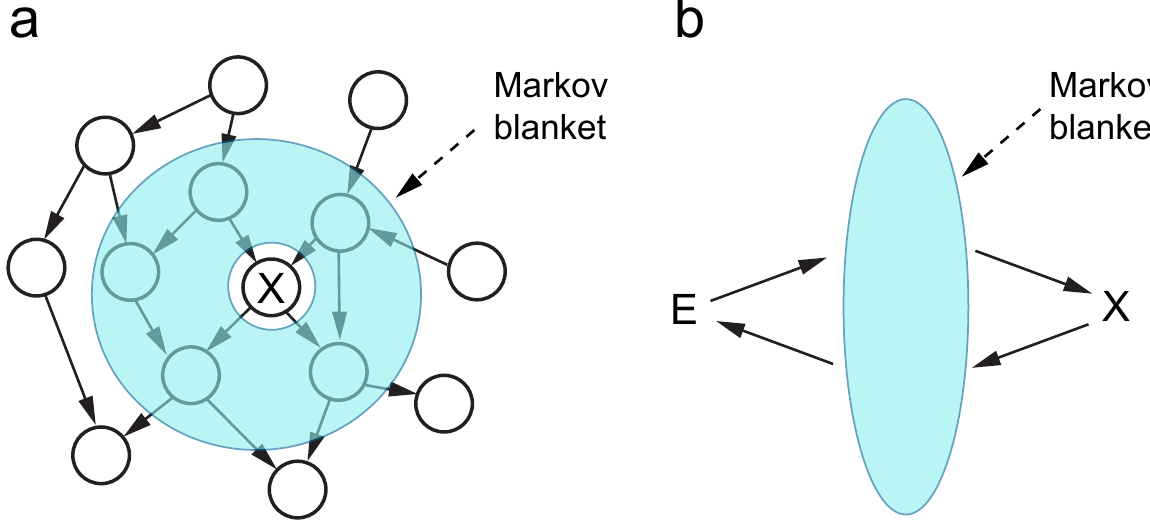
Figure 8: a) The Markov blanket of a node X in a causal network comprises the parents and children of X together with any other parents of X’s children. b) The Markov blanket is e ff ectively an information channel separating X from its environment E. Based on